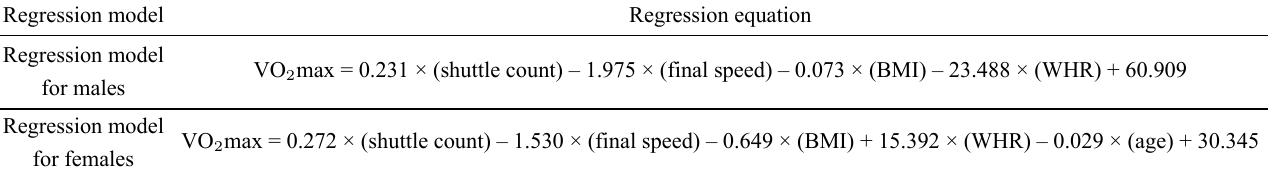
Table 8. The regression equation for prediction of VO 2 max using 10-m MST.